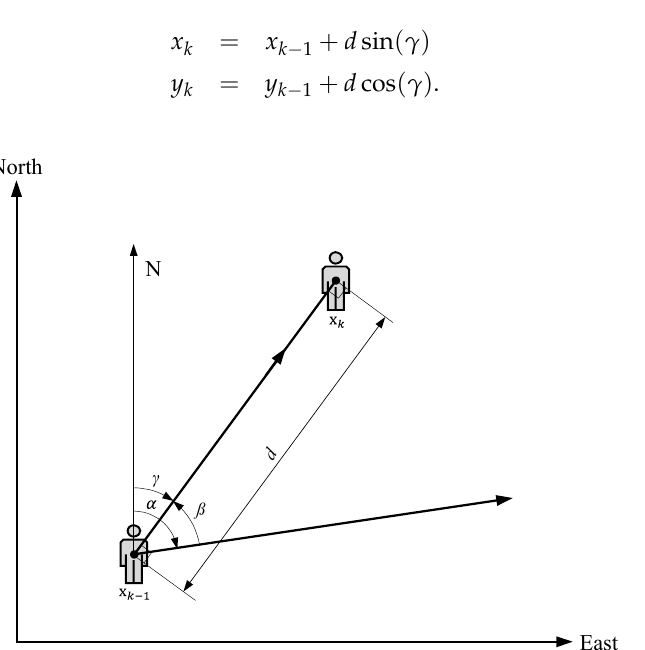
Figure 2. User motion model that takes into account the user’s x (east) and y (north) coordinates and heading angles at timesteps k and k −